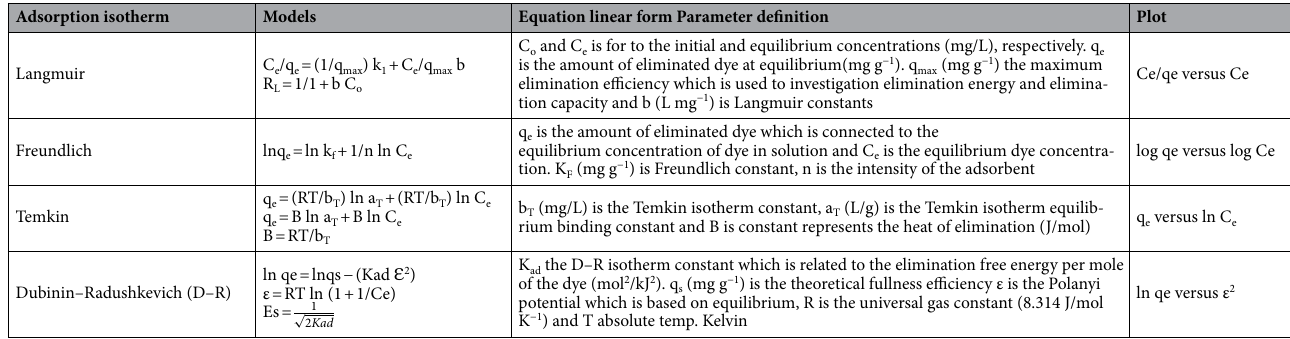
Table 5. Different evaluated isotherm models for biosorptive removal of BF dye by Gel@GO-F-ZrSiO 4 @Gel.